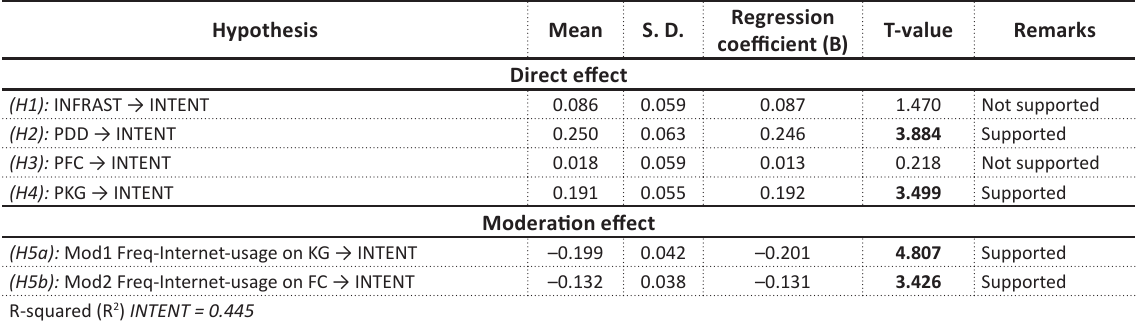
Source: Authors processing based on SmartPLS